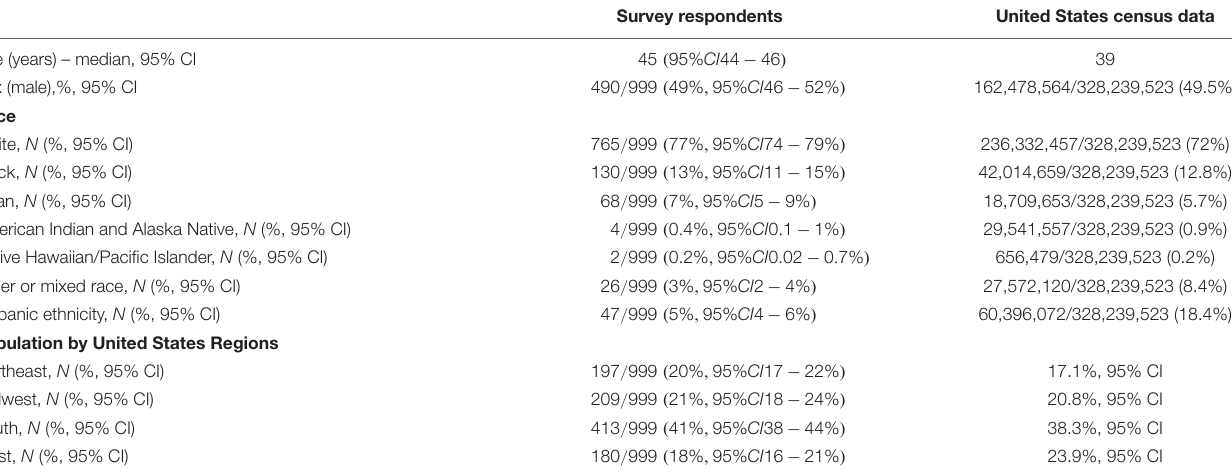
TABLE 1 | Demographics of survey respondents ( N = 999) compared to United States census data from 2020*. Survey respondents United States census